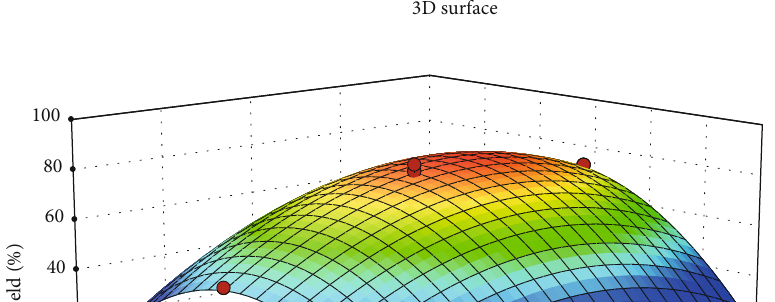
SO ) and time on FAME 2 4